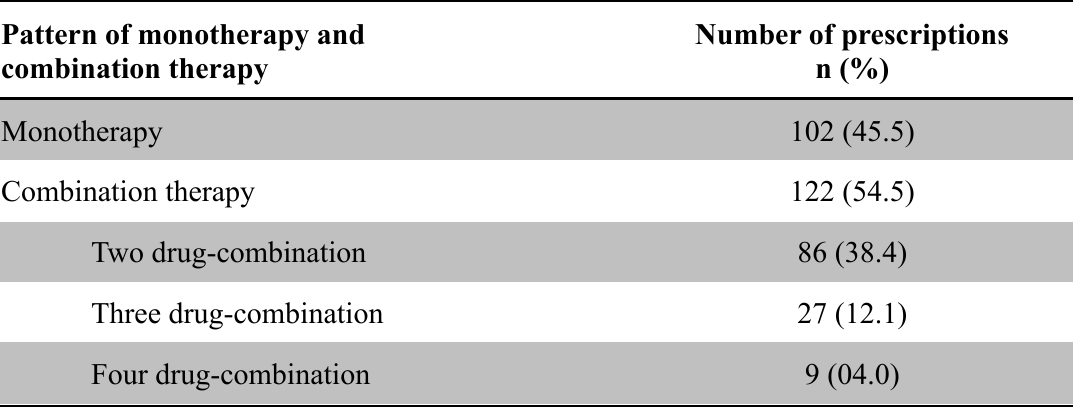
Table 4: Prescription pattern of monotherapy and combination therapy (N = 224) Pattern of monotherapy and